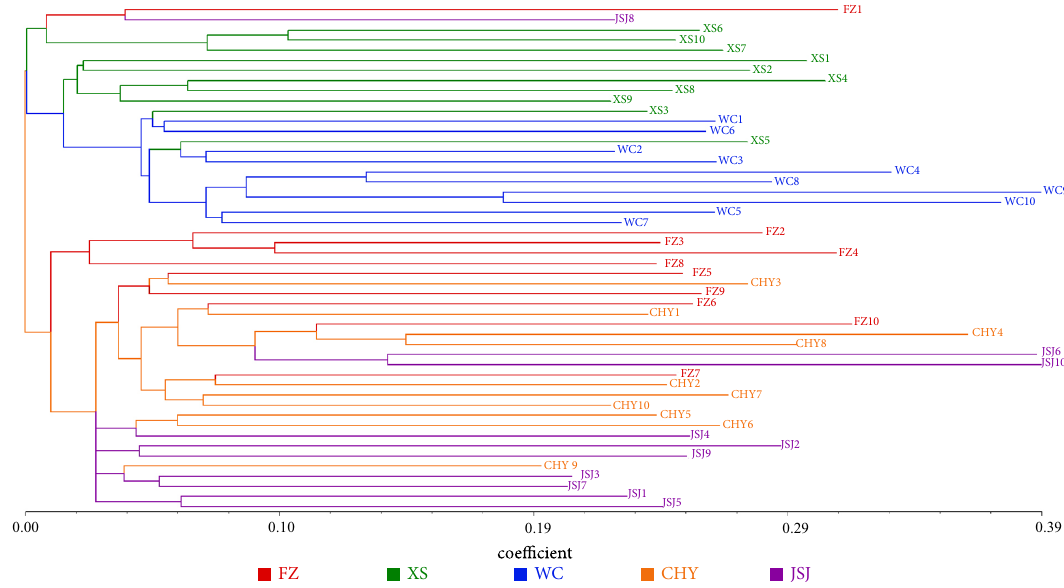
Figure 2. Neighbour-joining (NJ) phylogenetic tree of 50 rice from five different